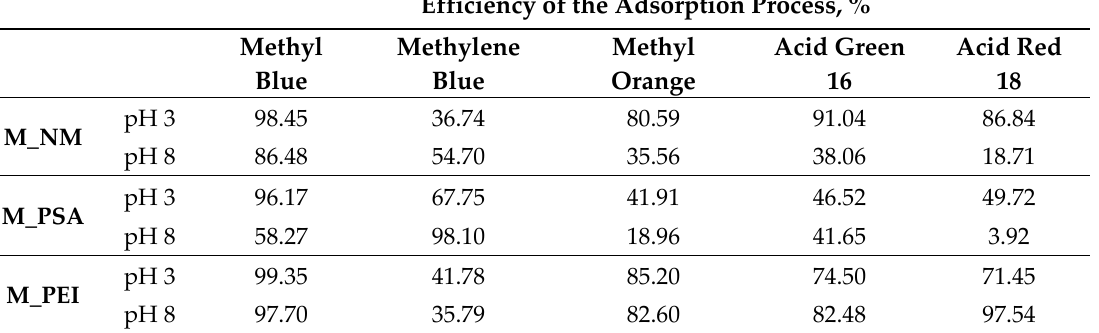
Table 1. Efficiency of the adsorption process. M_NM: unmodified magnetite; M_PSA: magnetite modified with sodium polyacrylate; M_PEI: magnetite modified with